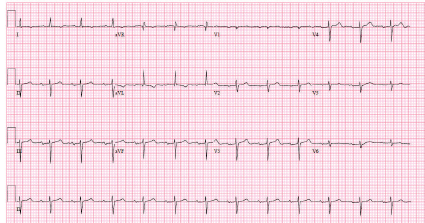
Figure 3: Resolution of 2: 1 AV block after revascularization; residual 1st-degree AV block (PR 220